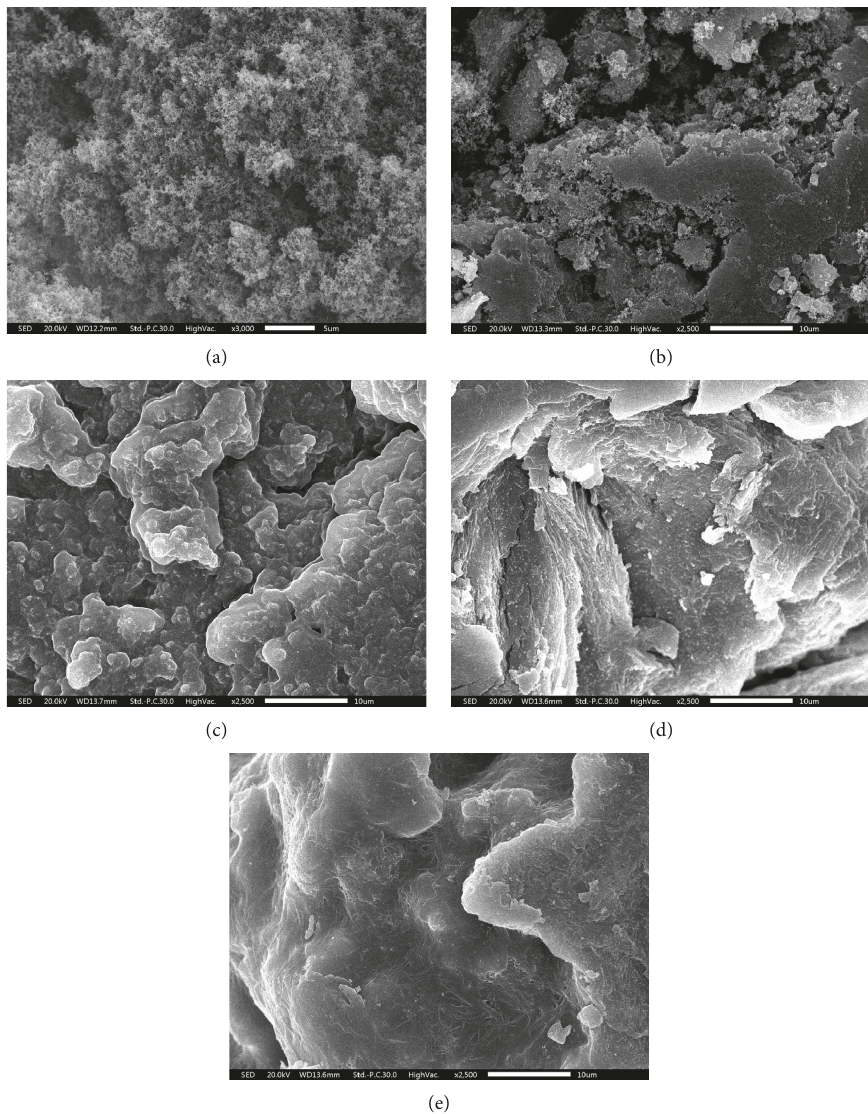
Figure 9: SEM images of the shape-stabilized composite PCMs. (a) AB. (b) PEG800/AB. (c) PEG4000/AB. (d) PEG6000/AB. (e)